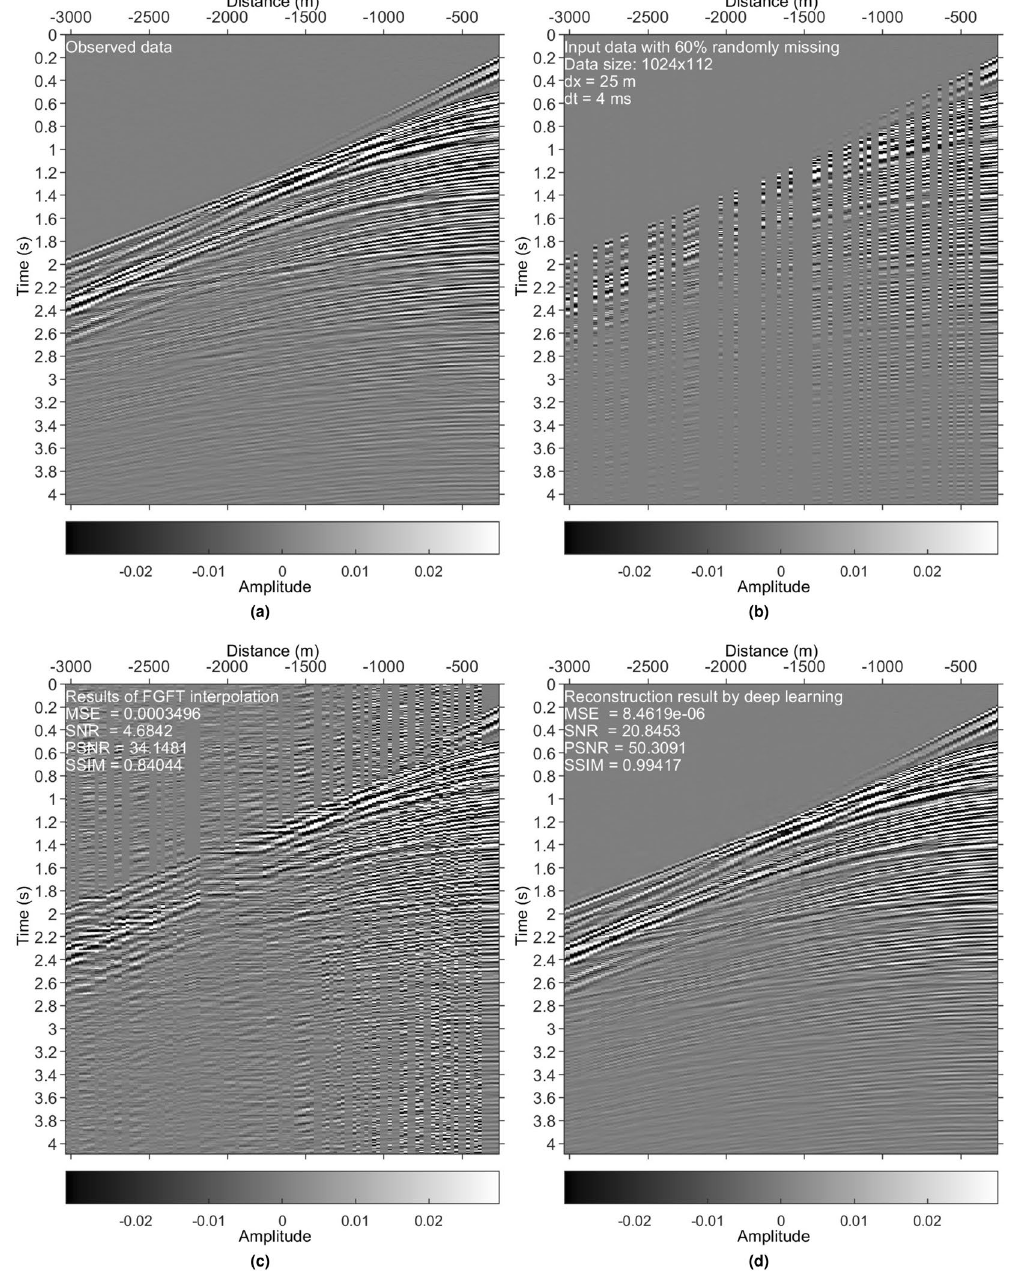
Figure 5. Results on the Mobil Viking graben line 12 data set. ( a ) Reference data. ( b ) Irregularly sampled data with 60% missing. ( c ) Interpolated data using the FGFT interpolation method 23 . ( d ) DL reconstruction